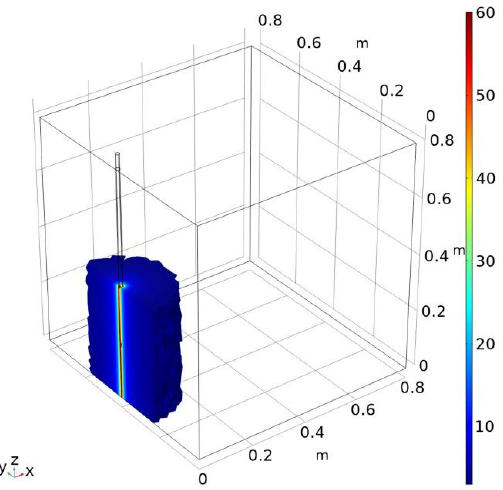
Figure 9. Simulation results of the grouting theoretical model considering the displacement effect.